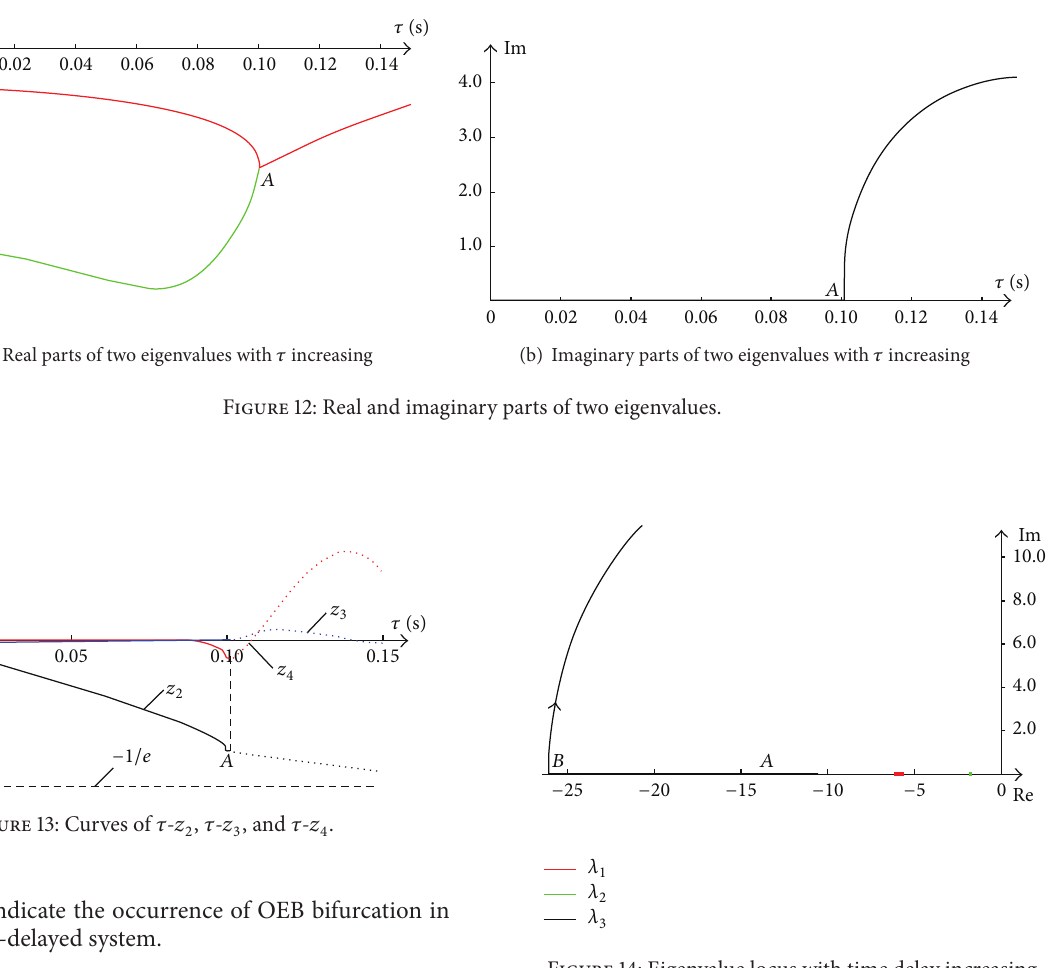
Figure 14: Eigenvalue locus with time delay increasing.